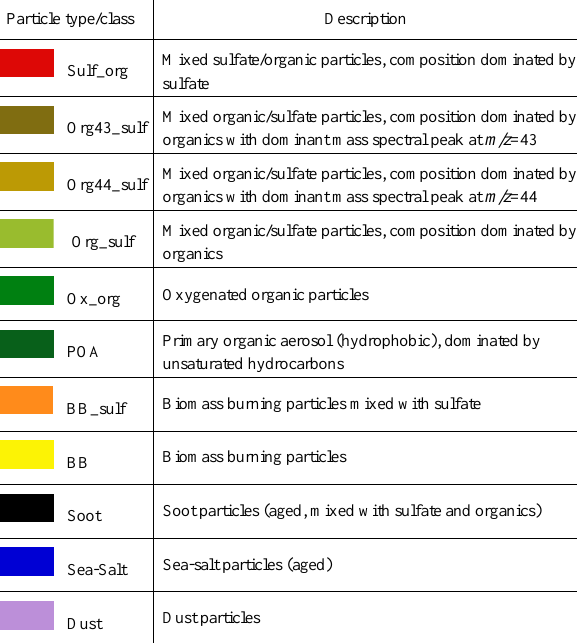
Table 1. Particle types determined by